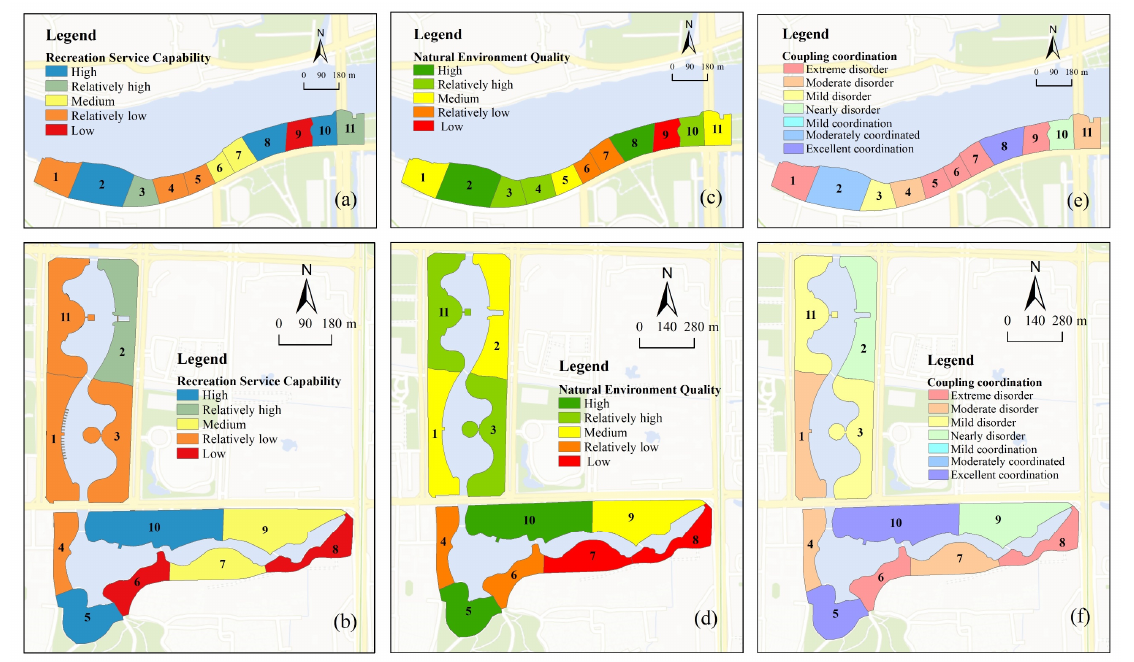
Figure 5. ( a , b ) Recreation service capacity. ( c , d ) Natural environment quality. ( e , f ) Coupling and coordination capacity.